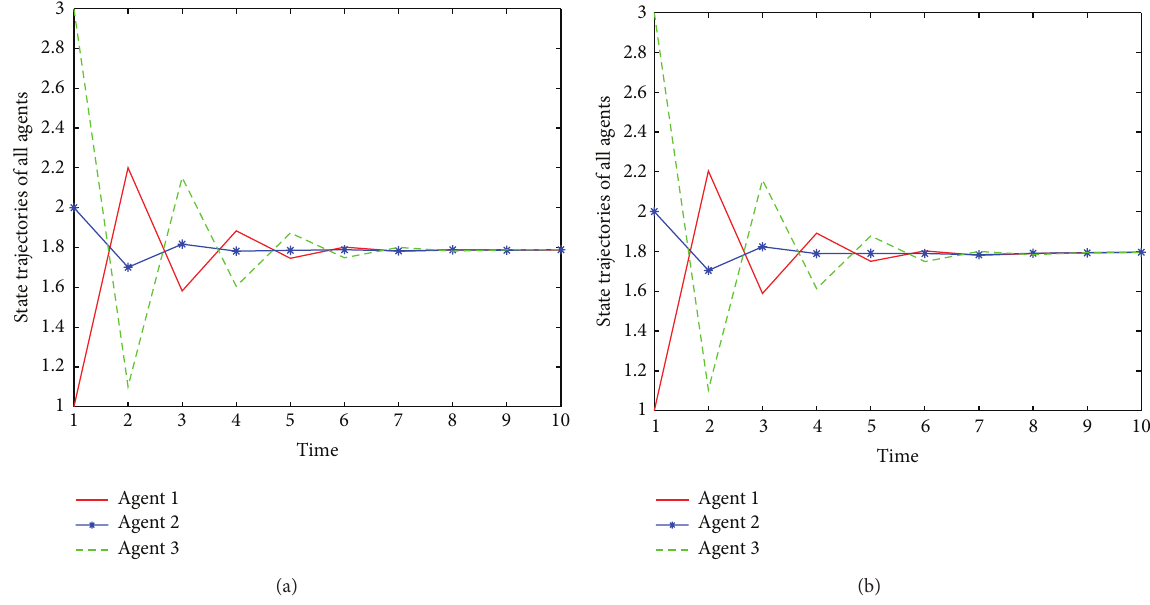
Figure 2: (a) State trajectories of all agents when 𝛾 = 0 . 001. (b) State trajectories of all agents when 𝛾 = 0 .